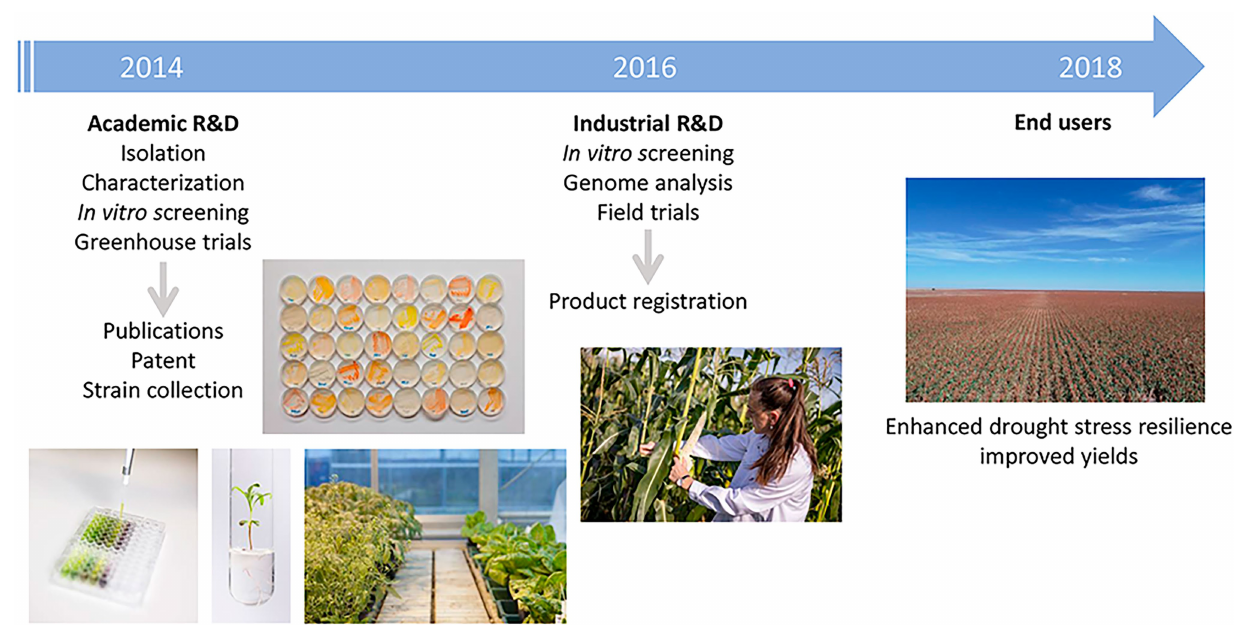
FIGURE 3 | Flowchart describing the development of the products for the improvement of drought-stress tolerance based on the microbial strain. The activities and main outputs of key academic and industrial partners are